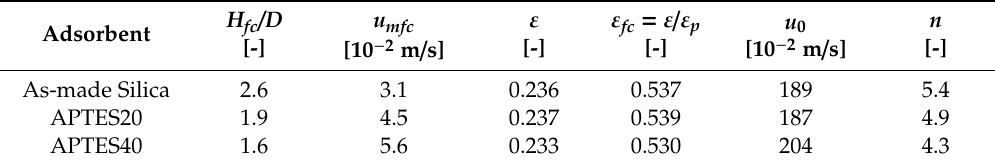
Figure 10. Homogeneous expansion trends for the three samples investigated in a confined bed: ( a ) as-made silica; ( b ) silica APTES20; ( c ) silica APTES40. Table 3. Fluidization properties of the adsorbent particles.